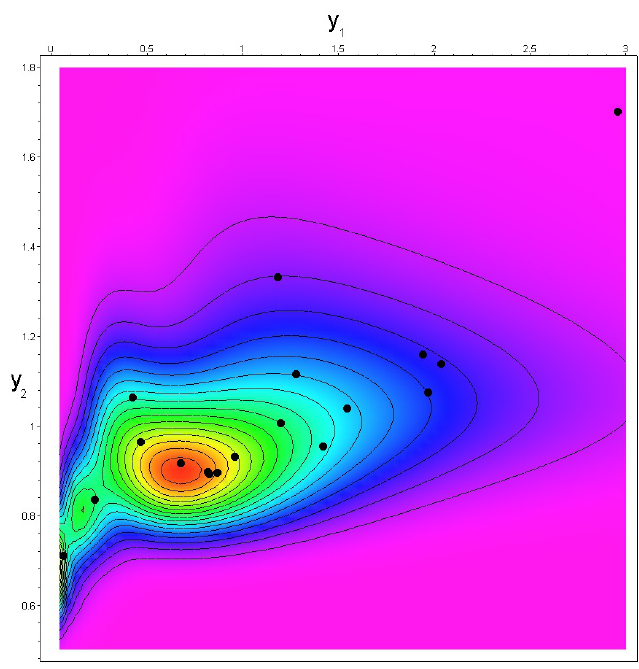
Figure 5. Contour plot of ˆ g ( y 1 , y 2 ) , m =